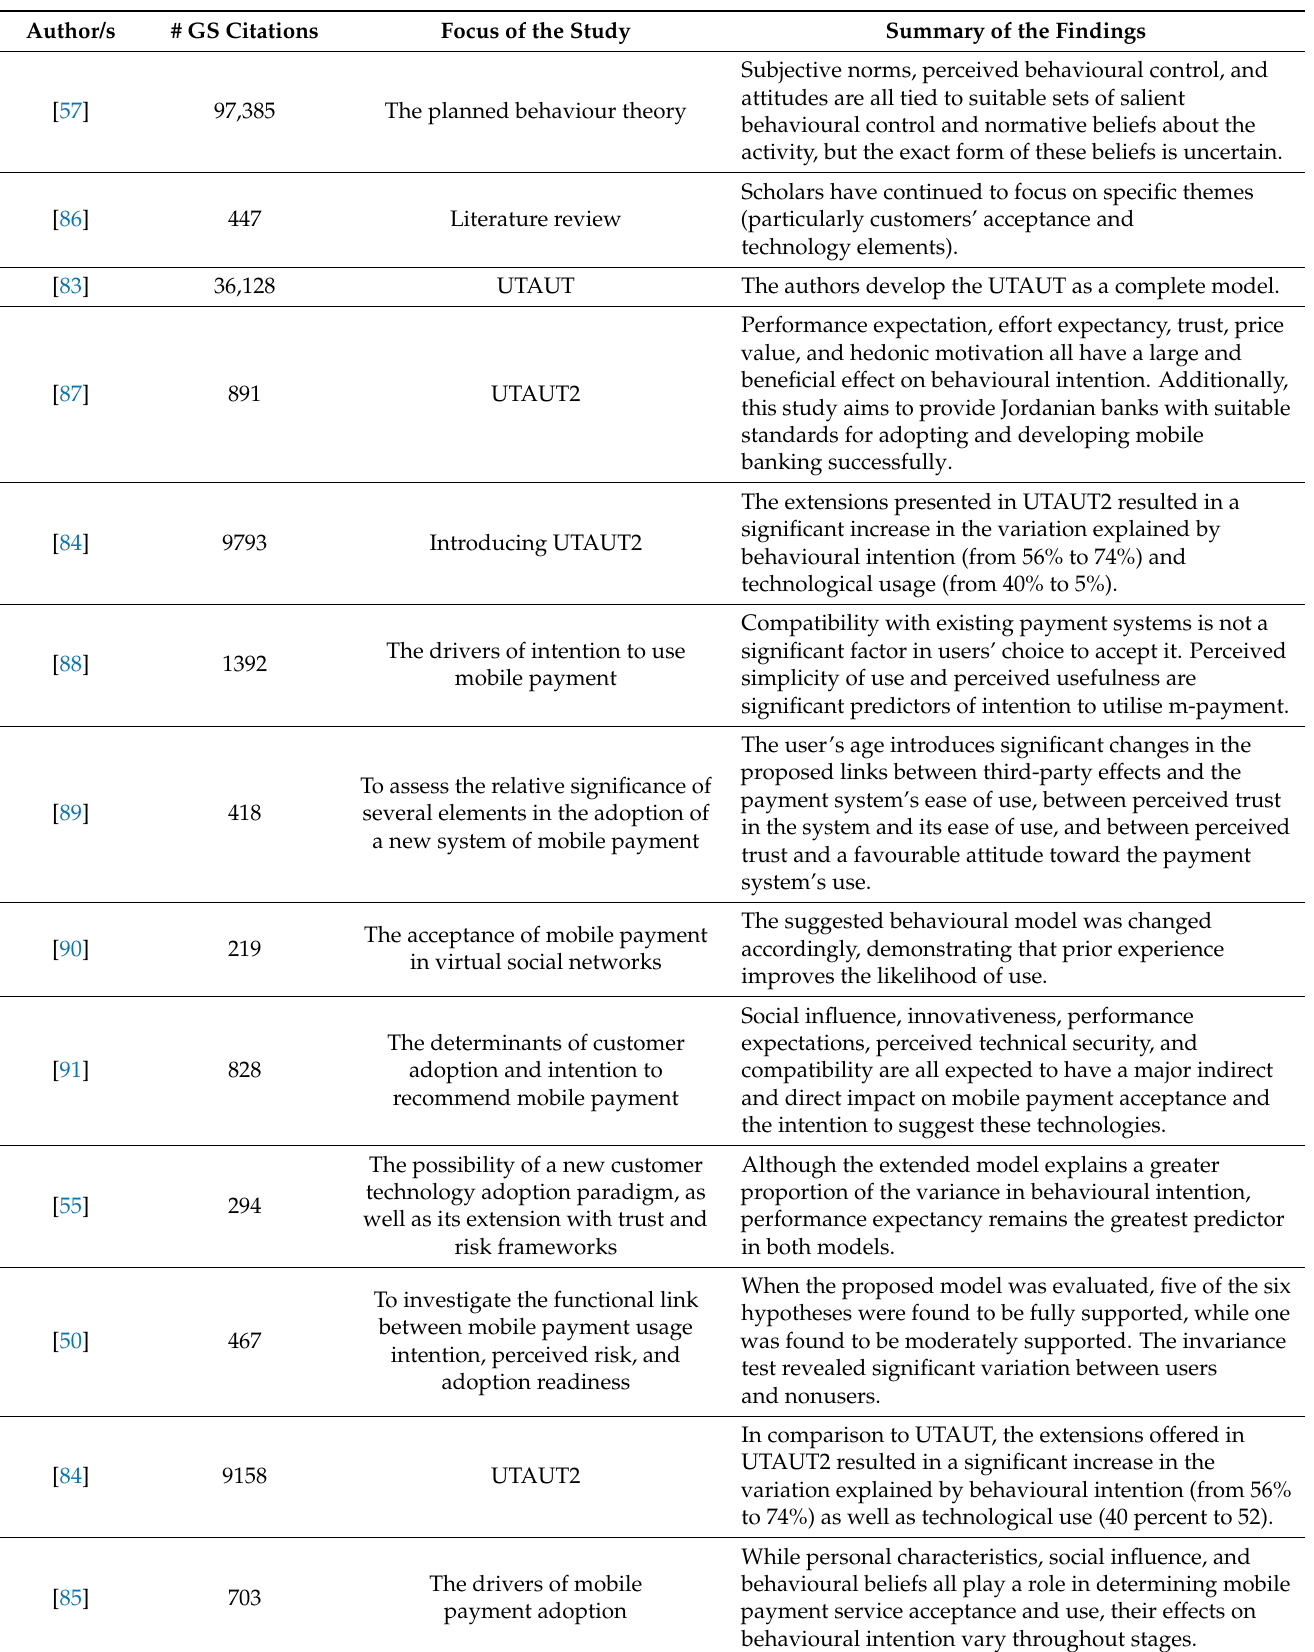
Table 6. Summary of studies in cluster